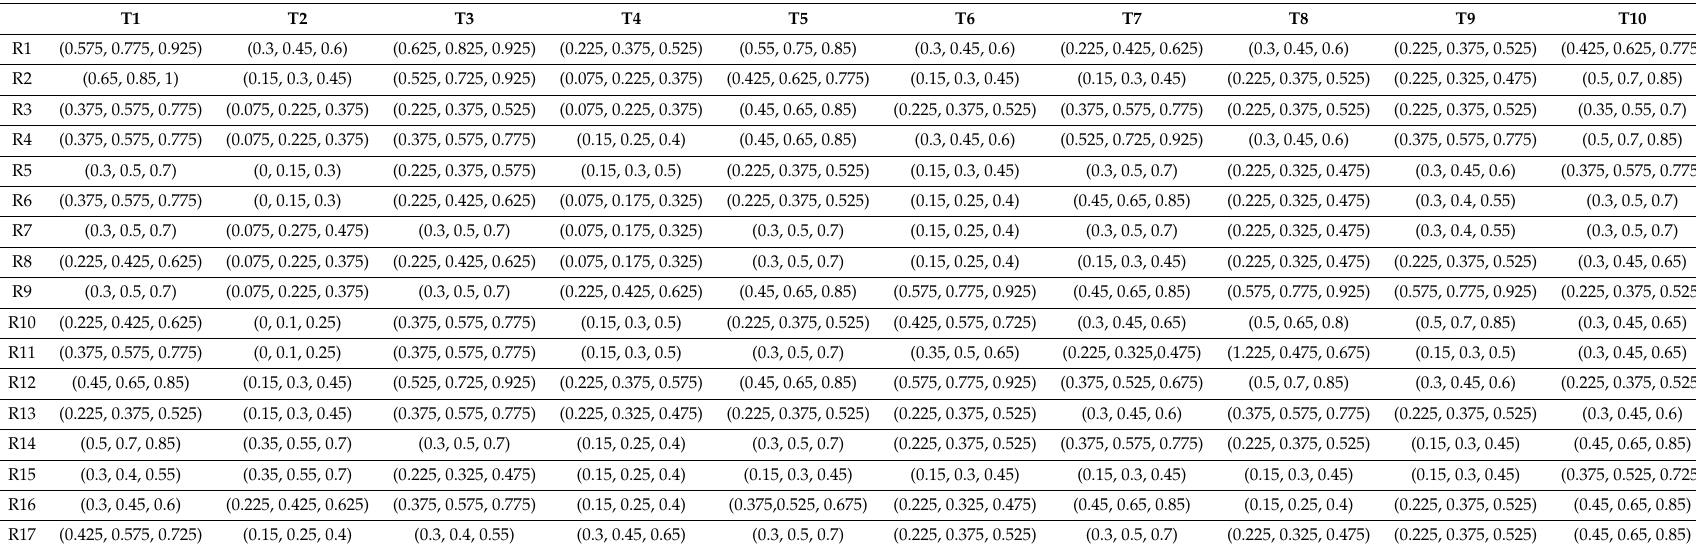
Table 4. Fuzzy relationship